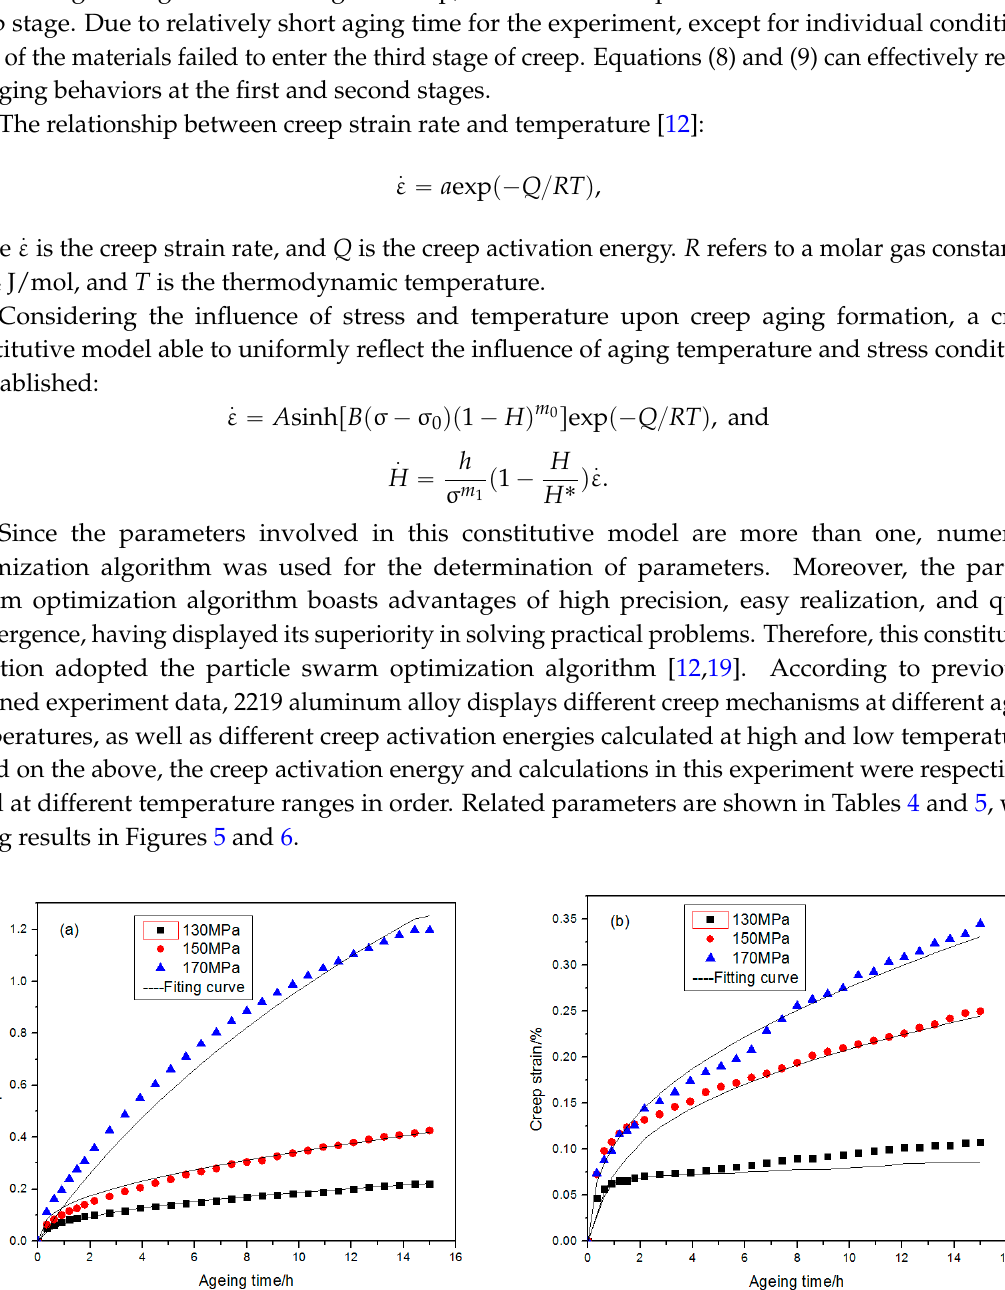
Figure 6. Comparison of fitted values and measured values of 2219 aluminum alloy creep curves at ( a ) 393 K and ( b ) 373 K. Table 4. Creep model parameters of 2219 aluminum alloy ( Q 1 = 96.2 kJ/mol). Material Constants